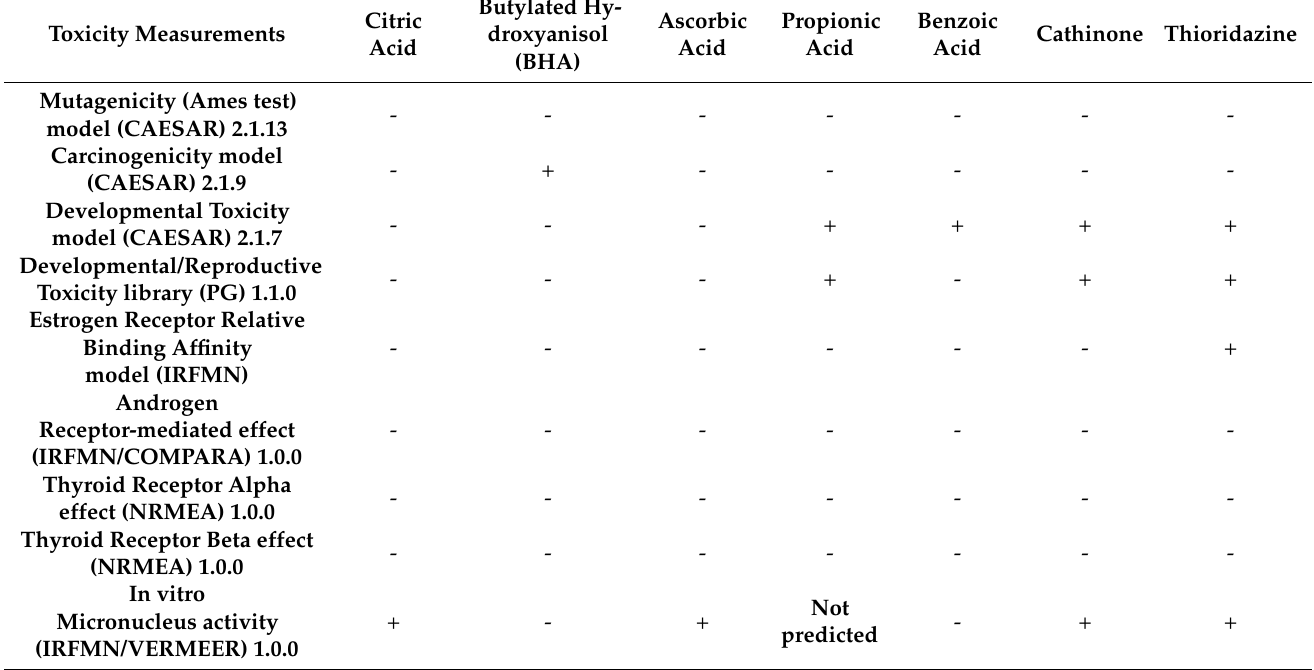
Table 4. Toxicity assessment of food preservatives and efflux pumps inhibitors (controls) using the Vega QSAR